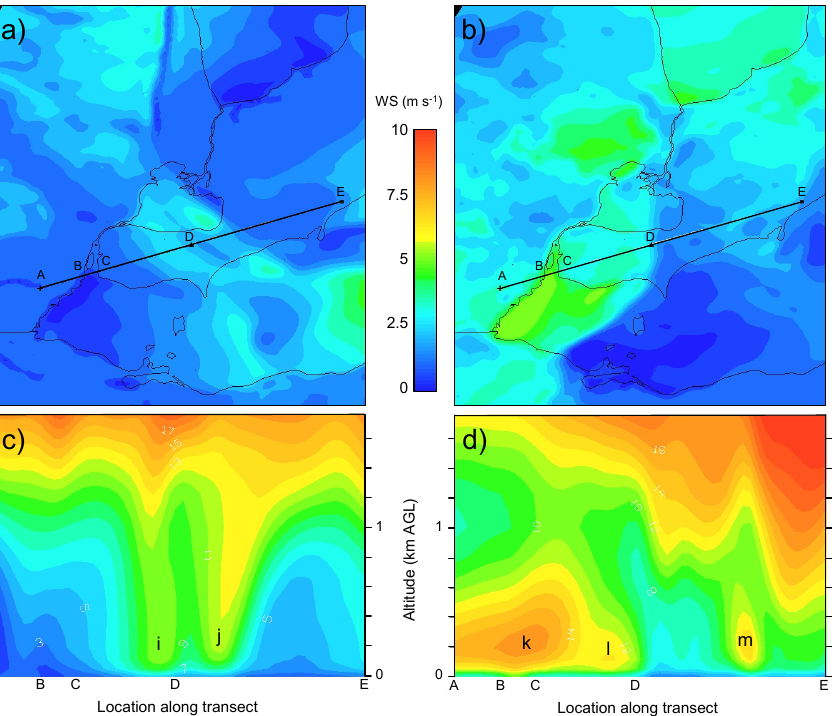
Fig. 13. Plan view at the surface (a, b) and vertical cross sections (c, d) of wind speed from the AURAMS model on the night of 6–7 July 2007 at 22:00EDT (a, c) and 03:20EDT (b,